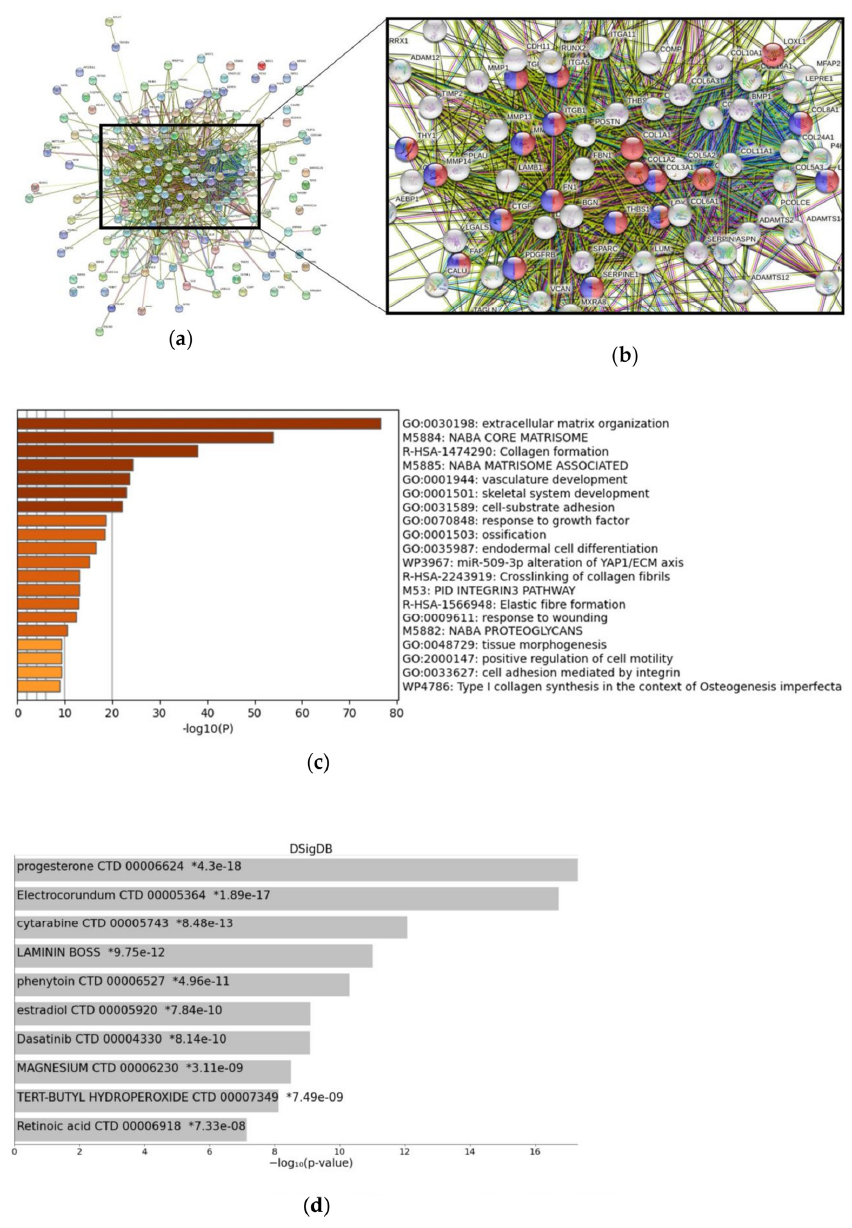
Figure 4. Gene networks, functions, and drug-induced gene signatures associated with FAP expression. ( a ) StringDB network analysis for 165 genes included. StringDB network focused on ( b ) the main complex of the network with marked biological processes “blood vessel development” (GO:0001568—red) and “blood vessel morphogenesis” (GO:0048514—blue). ( c ) Bar-graph summary of significantly enriched terms for genes overexpressed in FAP high-expressing samples as provided by Metascape analysis. ( d ) Drug-induced signatures (predicted via Drug Signatures Data- base) significantly related to FAP expression within the Random Forest learning approach. Drug Signatures Database was accessed via the EnrichR web portal.